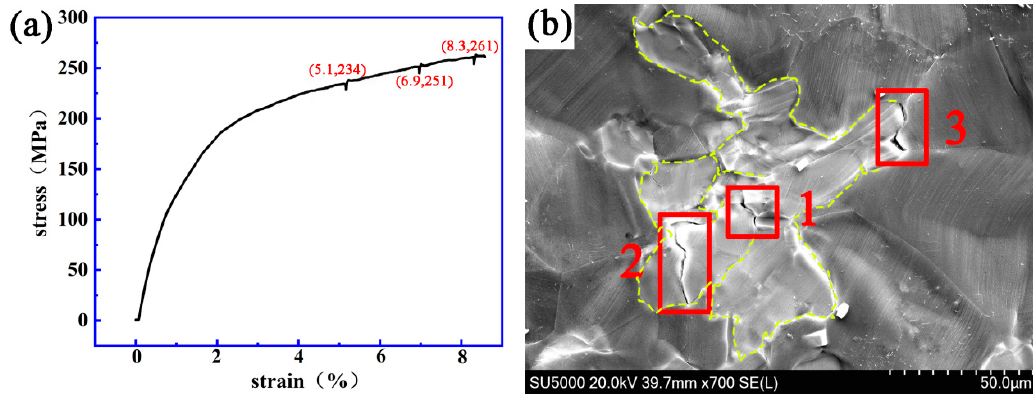
Figure 8. The dynamic change process of crack initiating and extending a Mg-13Gd-5Y-3Zn-0.3Zr alloy after solution treatment at 510 °C for 16 h. ( a ) The stress–strain curve. ( b ) The evolution process of the micro-crack.